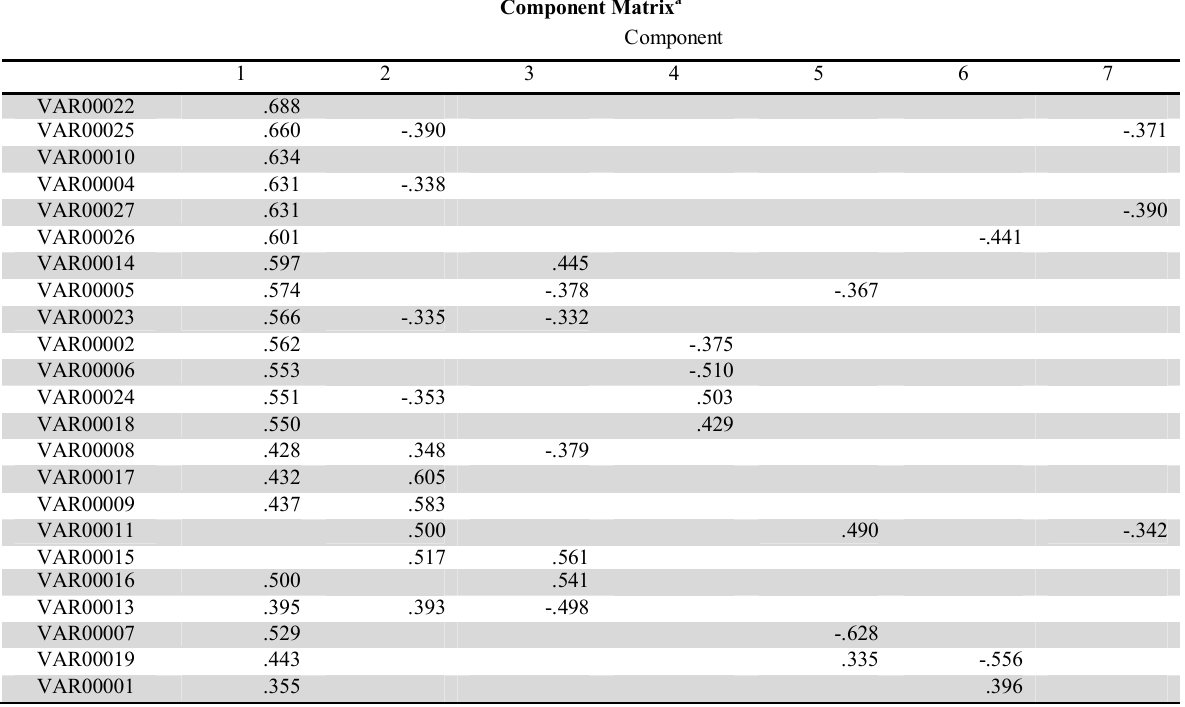
The results of principal component analysis before